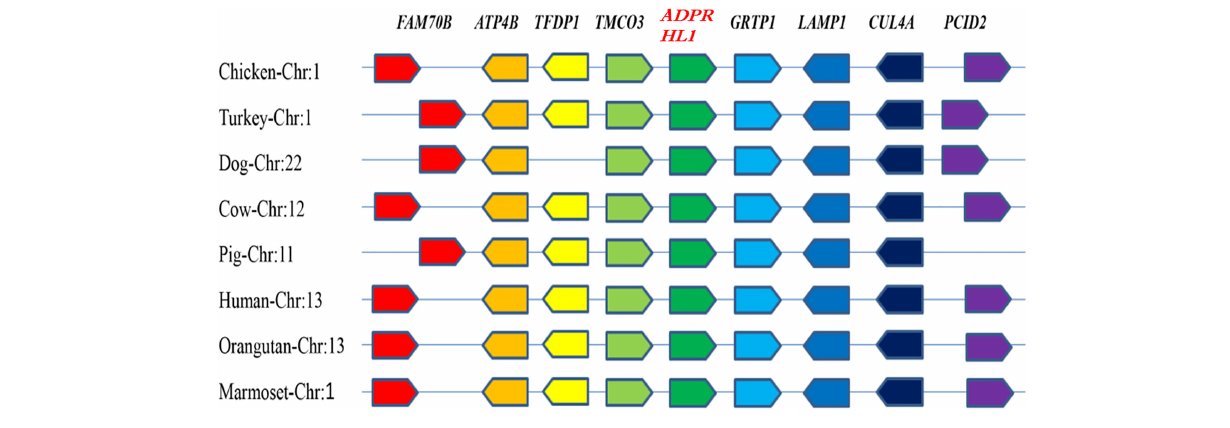
(GS, n = 284), Guifei chickens (GF, n = 156), Wuhei green- eggshell (WH, n = 441), Xichuan black-bone (XC, n = 572),